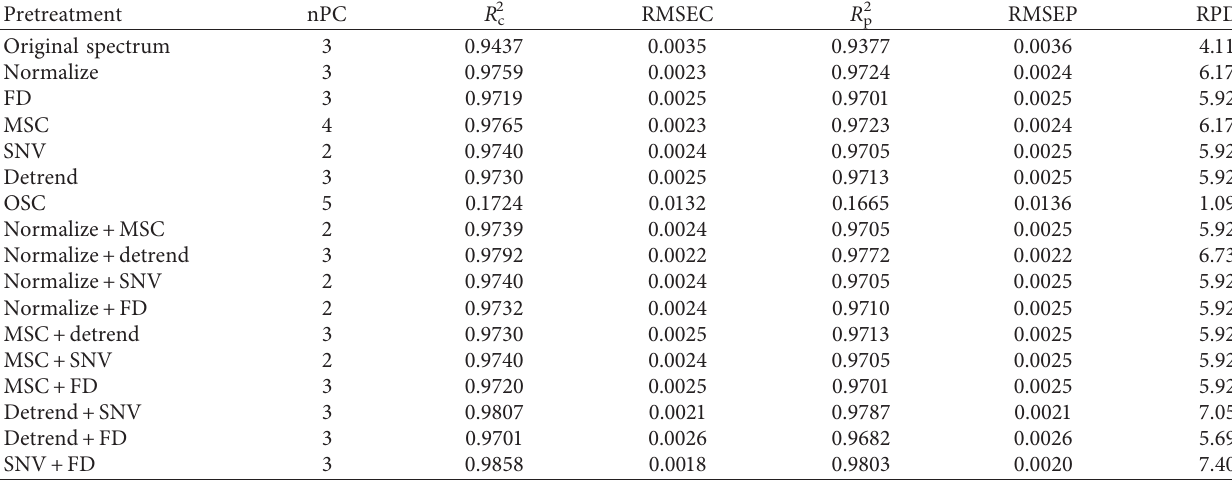
Table 2: Results of the calibration model for moisture content in walnut kernel with different pretreatment methods. Pretreatment